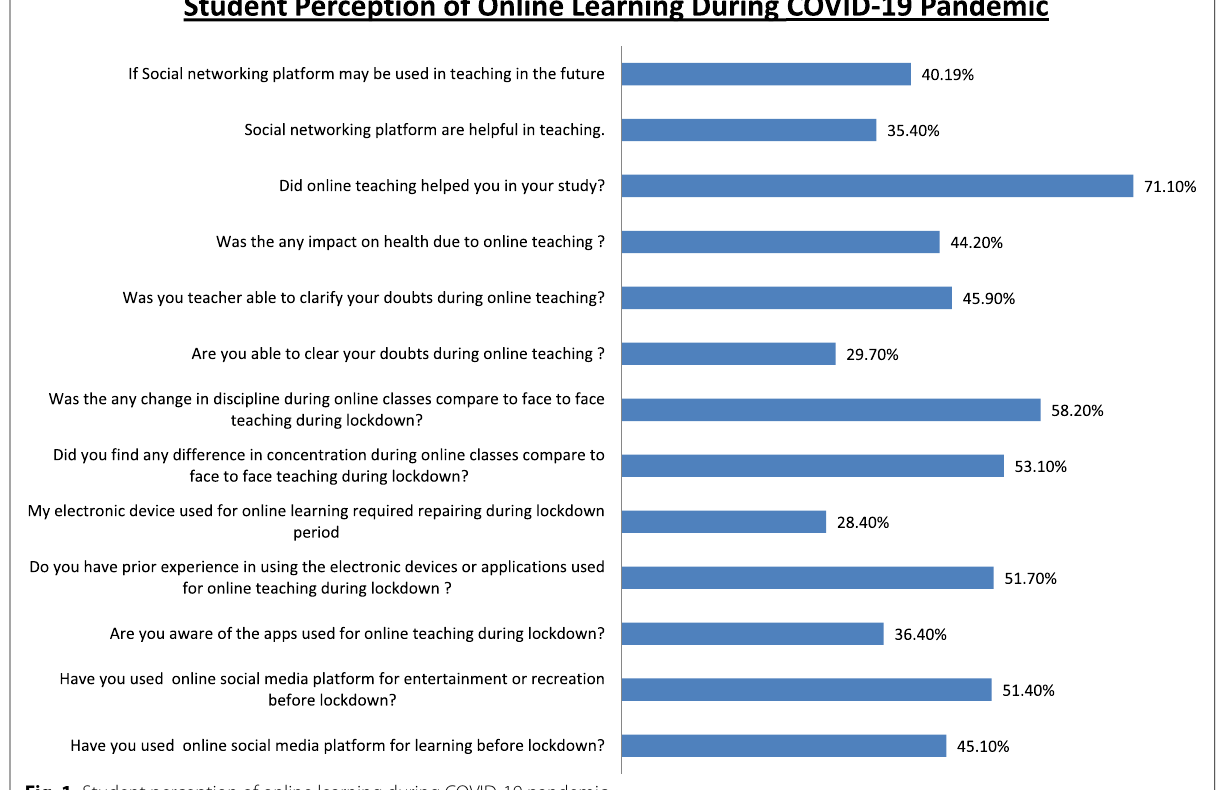
Fig. 1 Student perception of online learning during COVID-19